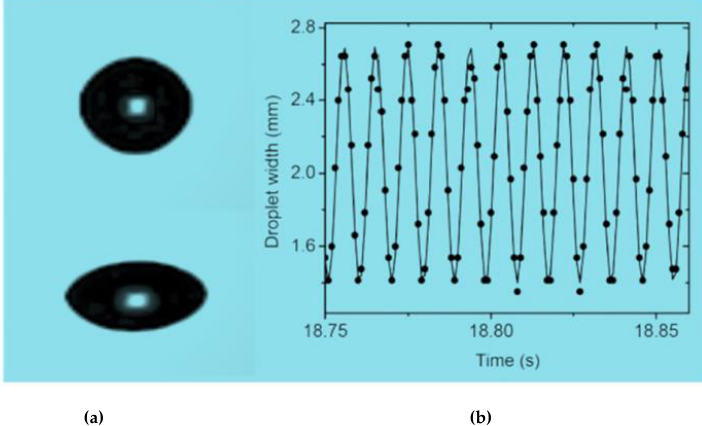
Figure 20. ( a ) Images of a relaxed and compressed drop modulated by cycling varying the acoustic levitation forces. ( b ) Plot of drop diameter vs time taken from images obtained using a Fastec IL3 camera. Image adapted from [58].